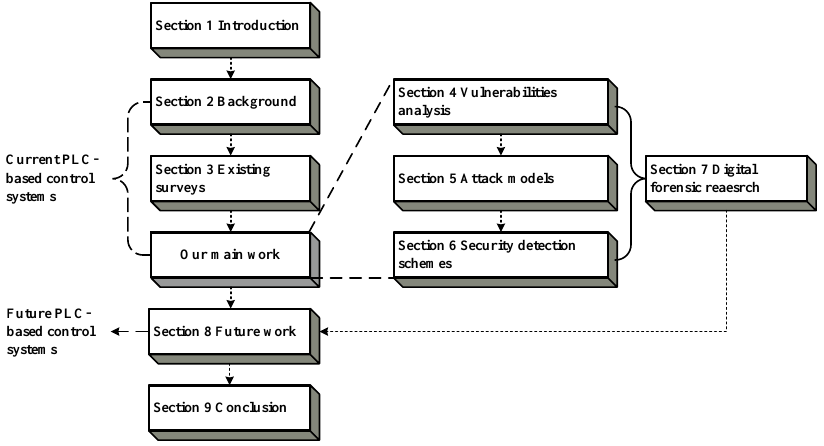
Figure 1. Review